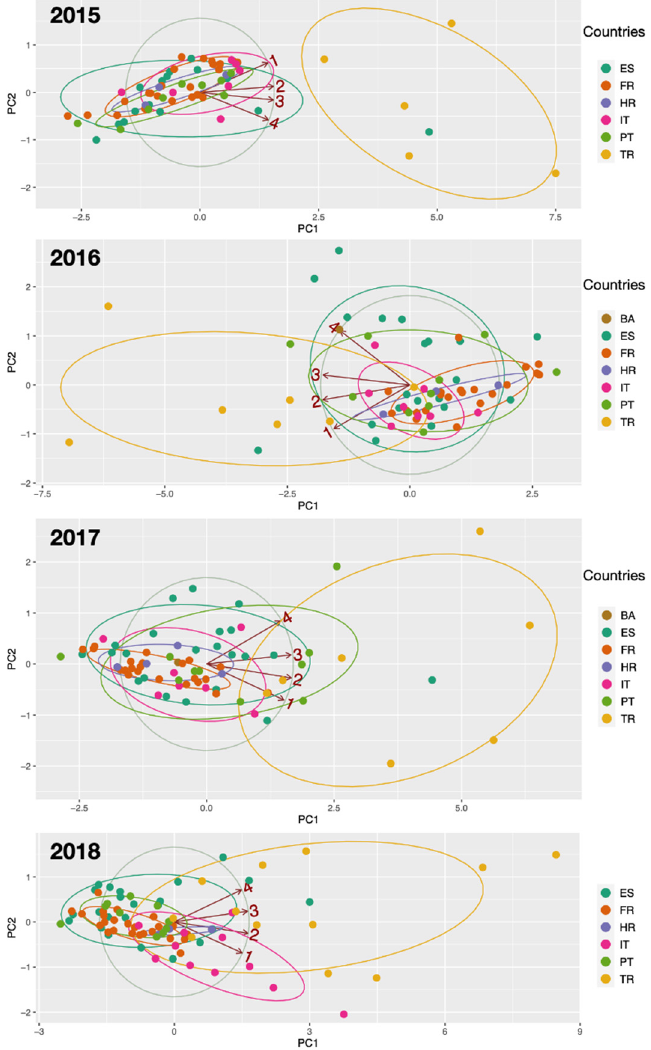
Figure 8. PCA biplot analysis for PM 10 (2015–2018), showing the relative position of monitoring stations by countries concerning the principal components. Four biplot vectors (in red) represent the four regimes of pollution as variables (1—first regime to 4—fourth regime). The 95% confidence interval ellipses are represented with a different colour for each country. BA—Bosnia and